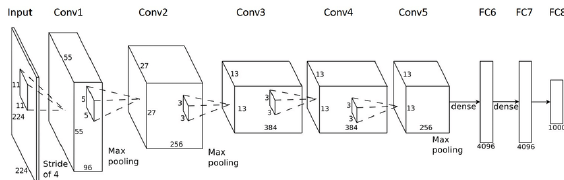
Figure 5. Schematic overview of the AlexNet architecture (Shehata,